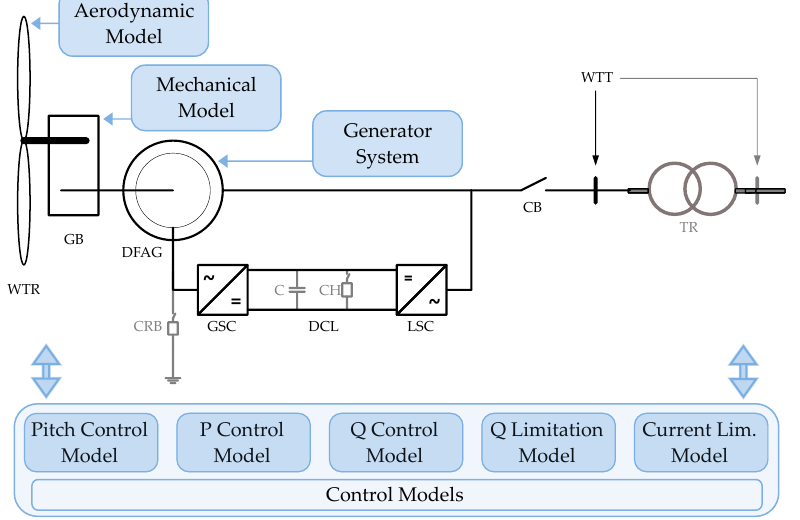
Figure 1. Single-line diagram and control models of generic Type 3 WT based on